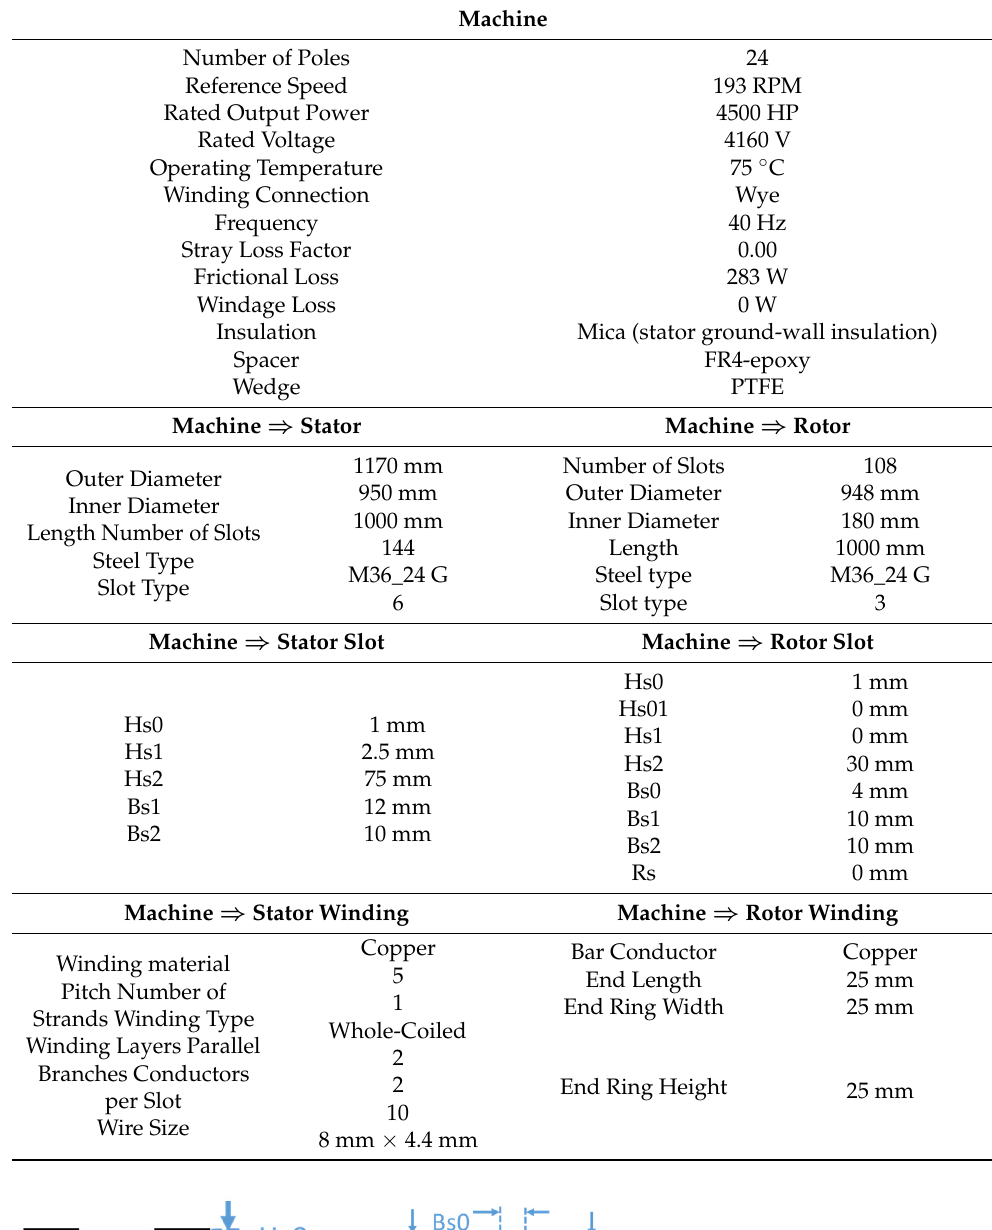
Table 1. Machine simulation parameters used in a Finite element model in Ansys Maxwell.